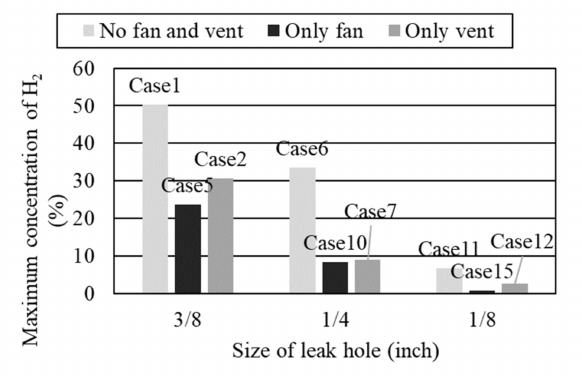
Figure 7. Size of leak hole and the maximum hydrogen